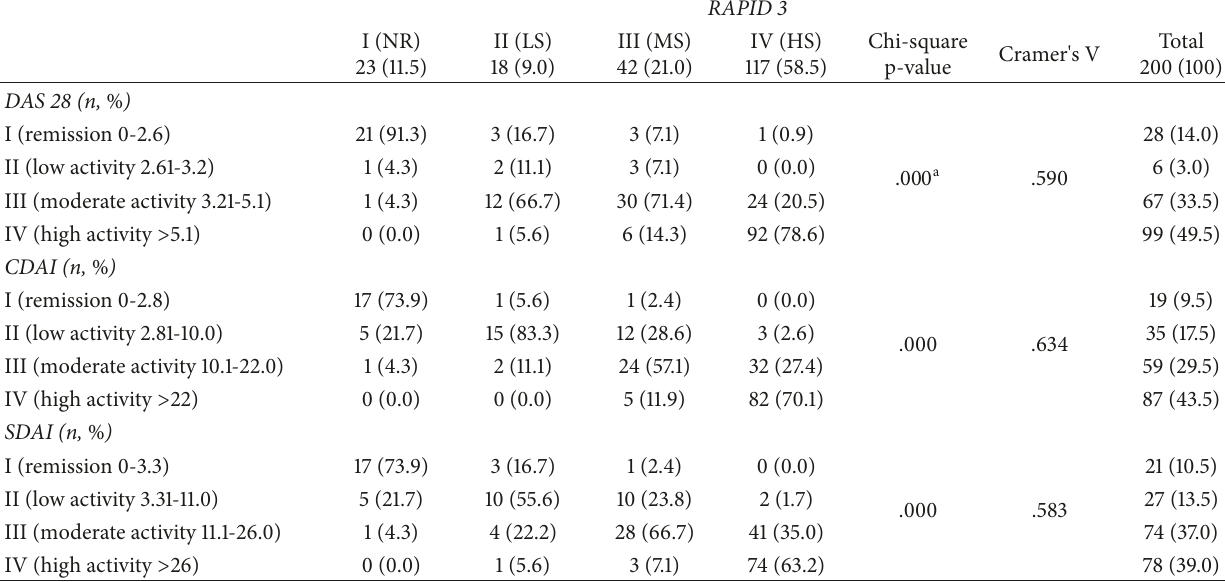
Table 3: DAS 28, CDAI and SDAI categories within RAPID 3